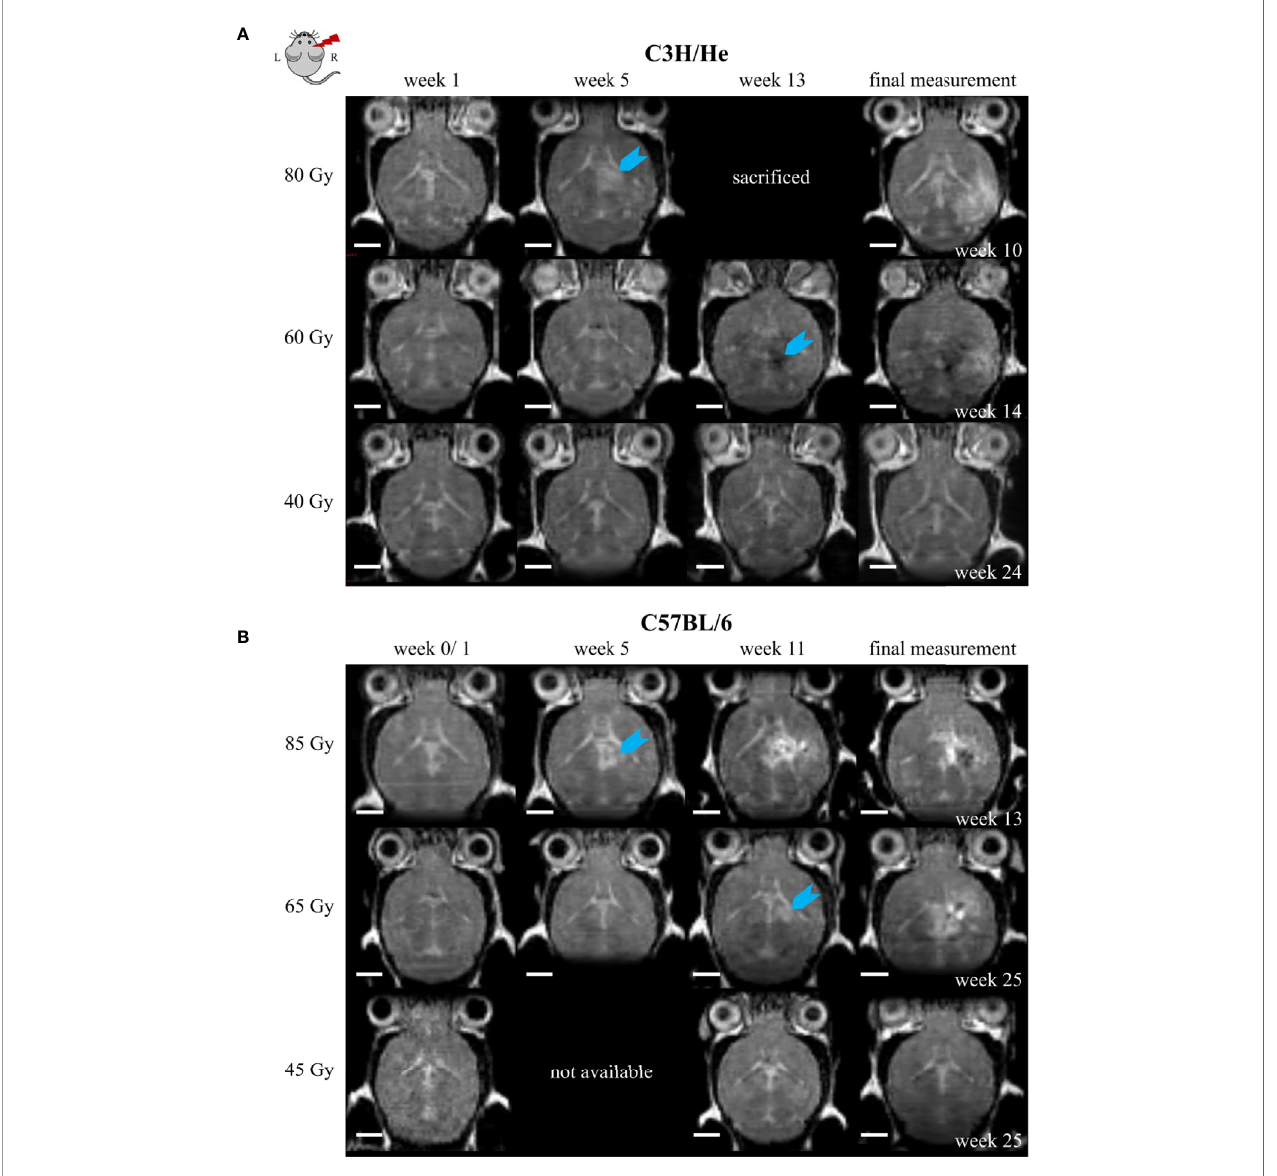
FIGURE 7 | Exemplary T2w MR images of (A) C3H/He and (B) C57BL/6 for one selected mouse per dose group. Signal onset (blue arrow) occurred faster in high dose animals and did not appear in the lowest dose group. In most animals, the initial T2w image change was a hyper-intense signal; however, hypo-intensities were observed fi rst in C3H/He mice irradiated with 60 Gy. Scale bars 2